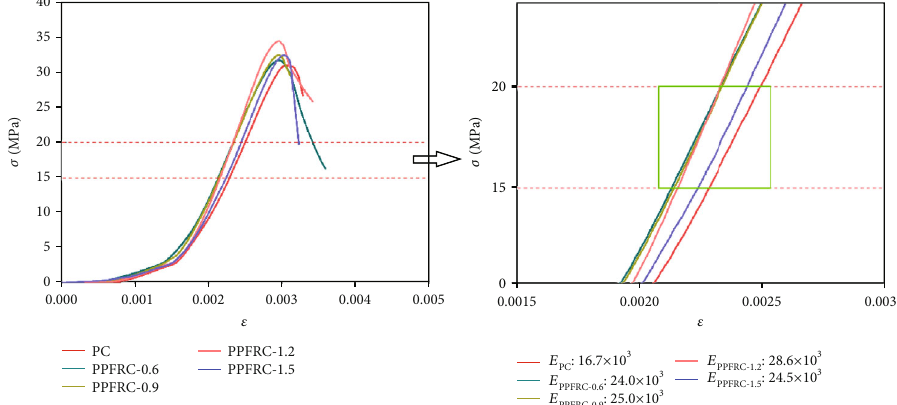
Figure 19: Uniaxial compressive stress-strain curve of PC and PPFRC at 28-day curing age.